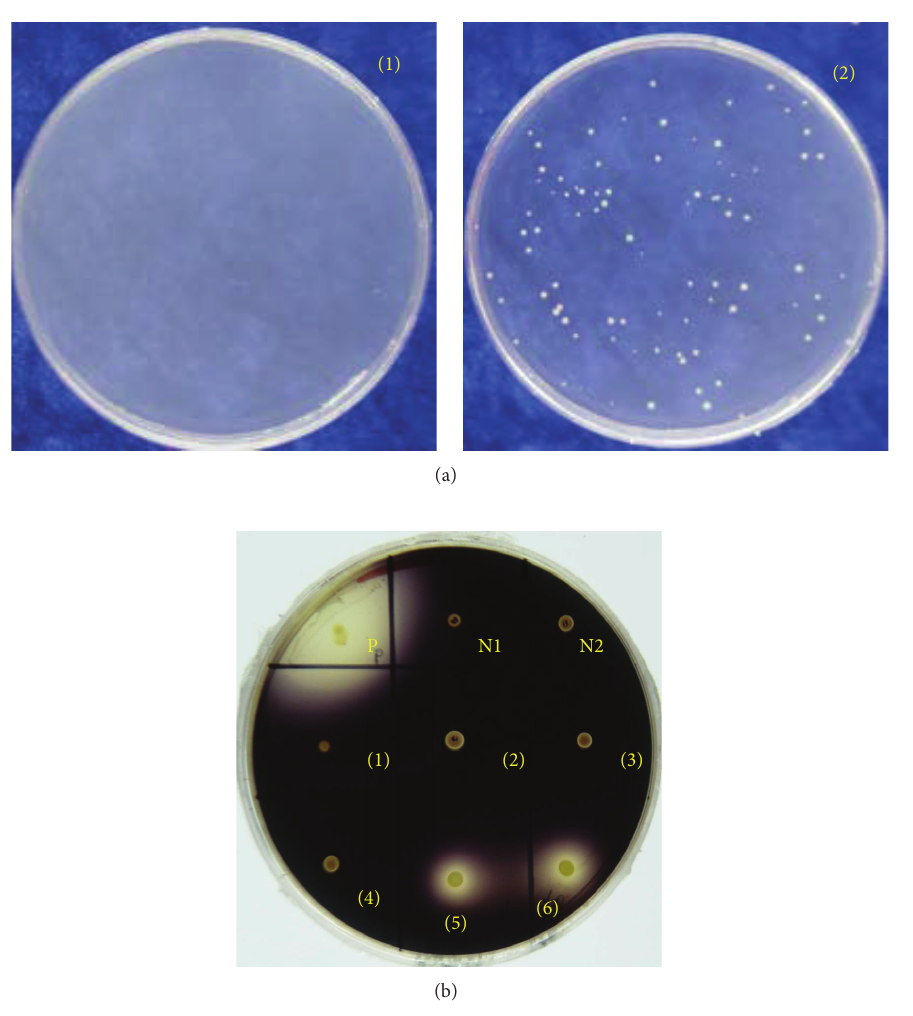
Figure 5: Expression of amyH gene in J7-2-1 via the integrative plasmid pUC19-HM1752- amyH . The plasmid pUC19-HM1752- amyH containing amyH was transformed into strain J7-2-1. Twenty-nine transformants were picked out randomly and cultured. Amylase activity in these transformants was detected on an MGM plate supplied with 2% (w/v) soluble starch. (detailed process is discussed in Materials and Methods).Theplatewasfloodedwith0.3%I 2 /0.6%KIsolutionafterincubationat42 ∘